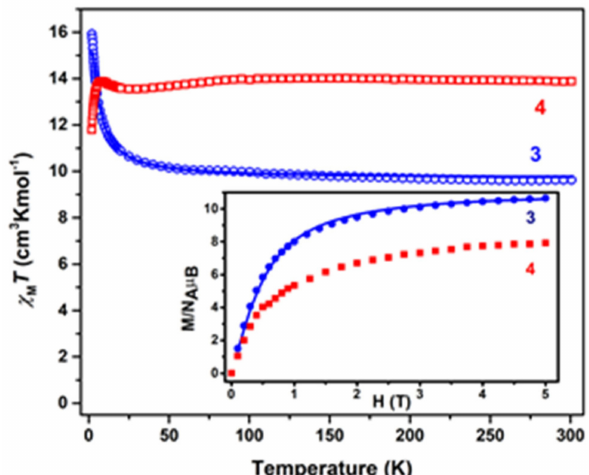
Figure 4. Plots of χ M T vs. T at 1000 Oe and M vs. H at 2 K (inset) for 3 (blue) and 4 (red). Solid lines for 3 represent the best fit obtained with the magnetic model described in the